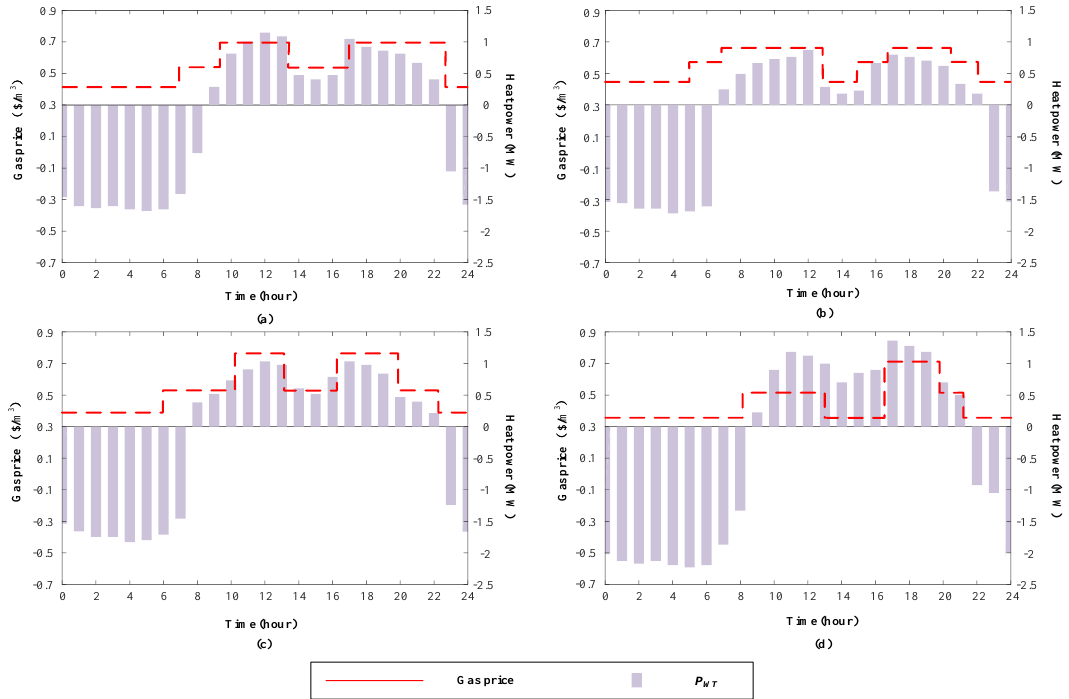
Figure 9. Optimal thermal storage output and time-of-use gas price in ( a ) spring; ( b ) summer; ( c ) autumn; ( d ) winter.